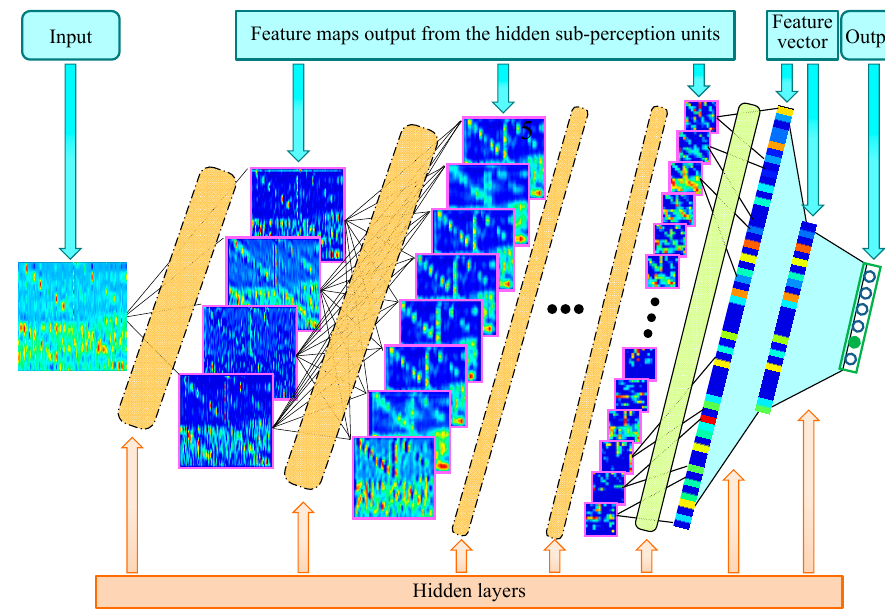
Figure 4. The basic architecture of the convolutional neural network (CNN) model.